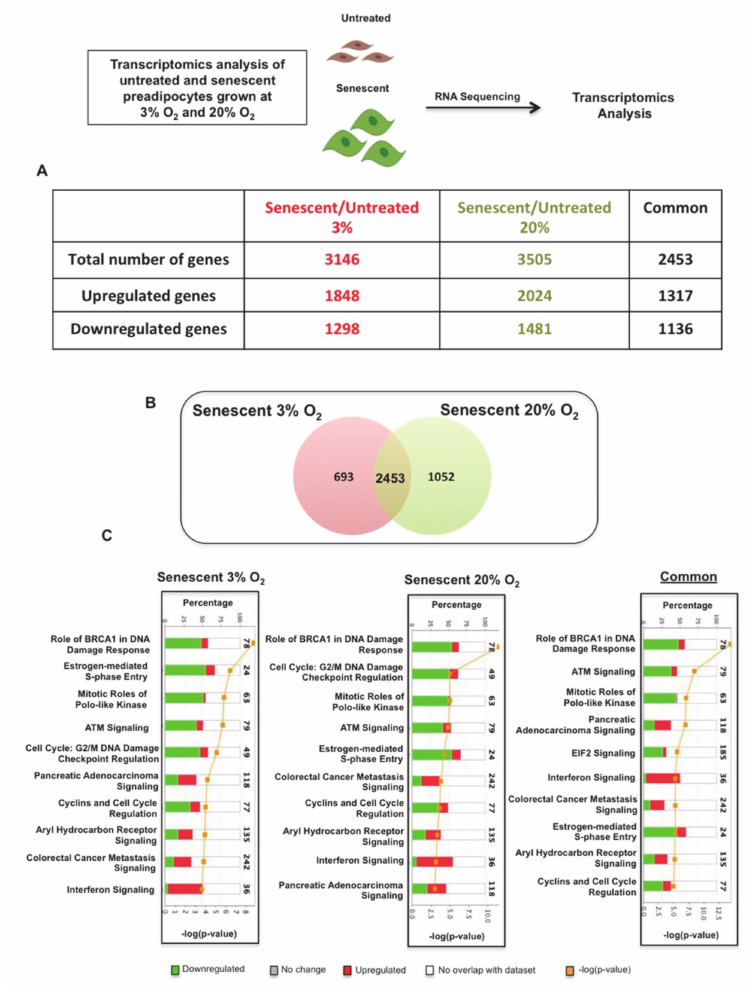
Figure 2. Transcriptomics analysis reveals common senescence signalling pathways in senescent preadipocytes grown at 3% O 2 or atmospheric 20% O 2 conditions. ( A ) List of the number of statisti- cally significant transcriptomics changes in senescent preadipocytes grown at either 3% O 2 or 20% O 2 and the number of common genes between the two conditions compared to their respective untreated control. Highlighted in red and green are the numbers of up-regulated and down-regulated gene products respectively. ( B ) Venn diagram shows the overlap of genes between senescent preadipocytes cultured at 3% O 2 and atmospheric O 2 . ( C ) 10 most significant canonical pathways that are altered in senescent preadipocytes grown at 3% O 2 , atmospheric O 2 , and common genes as indicated. Axes show percentages of overlapped genes in each pathway and p -value of overlap (Ingenuity Pathway Analysis (IPA) generated). Highlighted in red and green is the percentage of up-regulated and down-regulated genes products in each pathway,